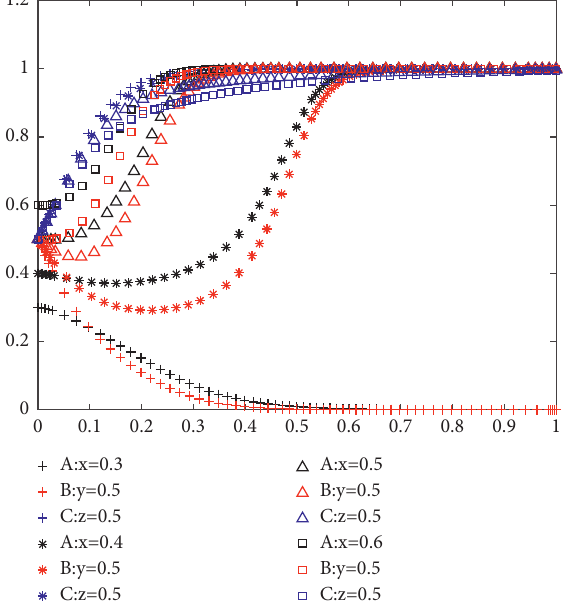
Figure 2: Evolutionary analysis of initial willingness to participate in cooperation (x)